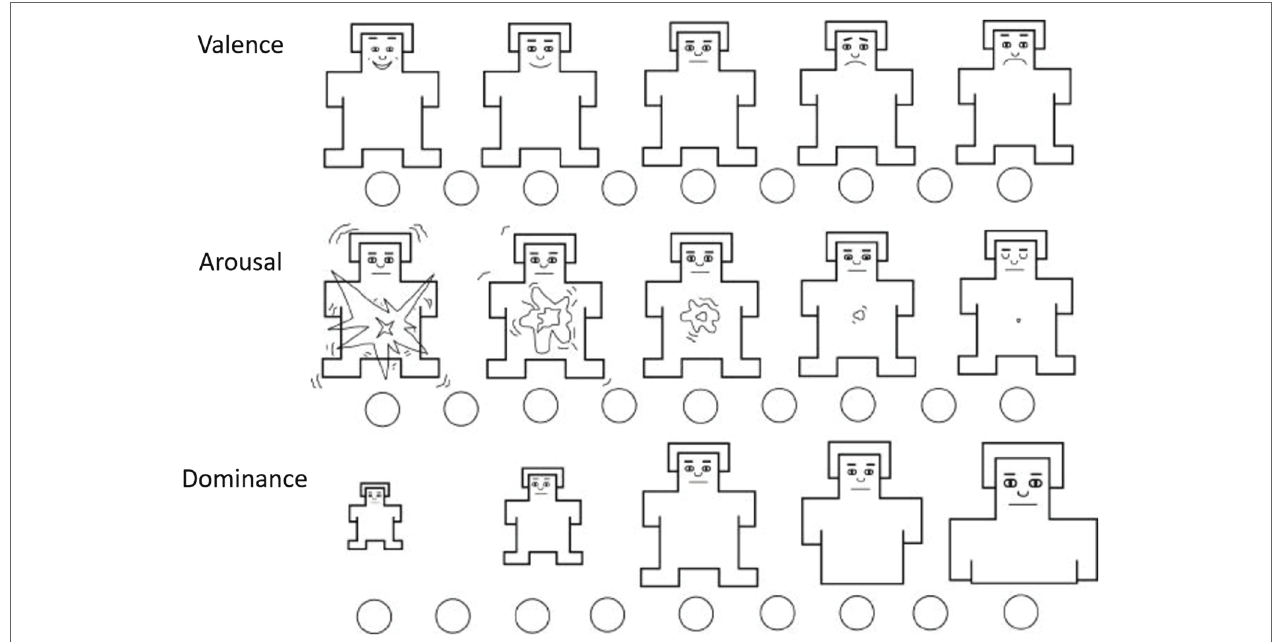
FIGURE 2 | SAM questionnaire. Source: Bradley and Lang